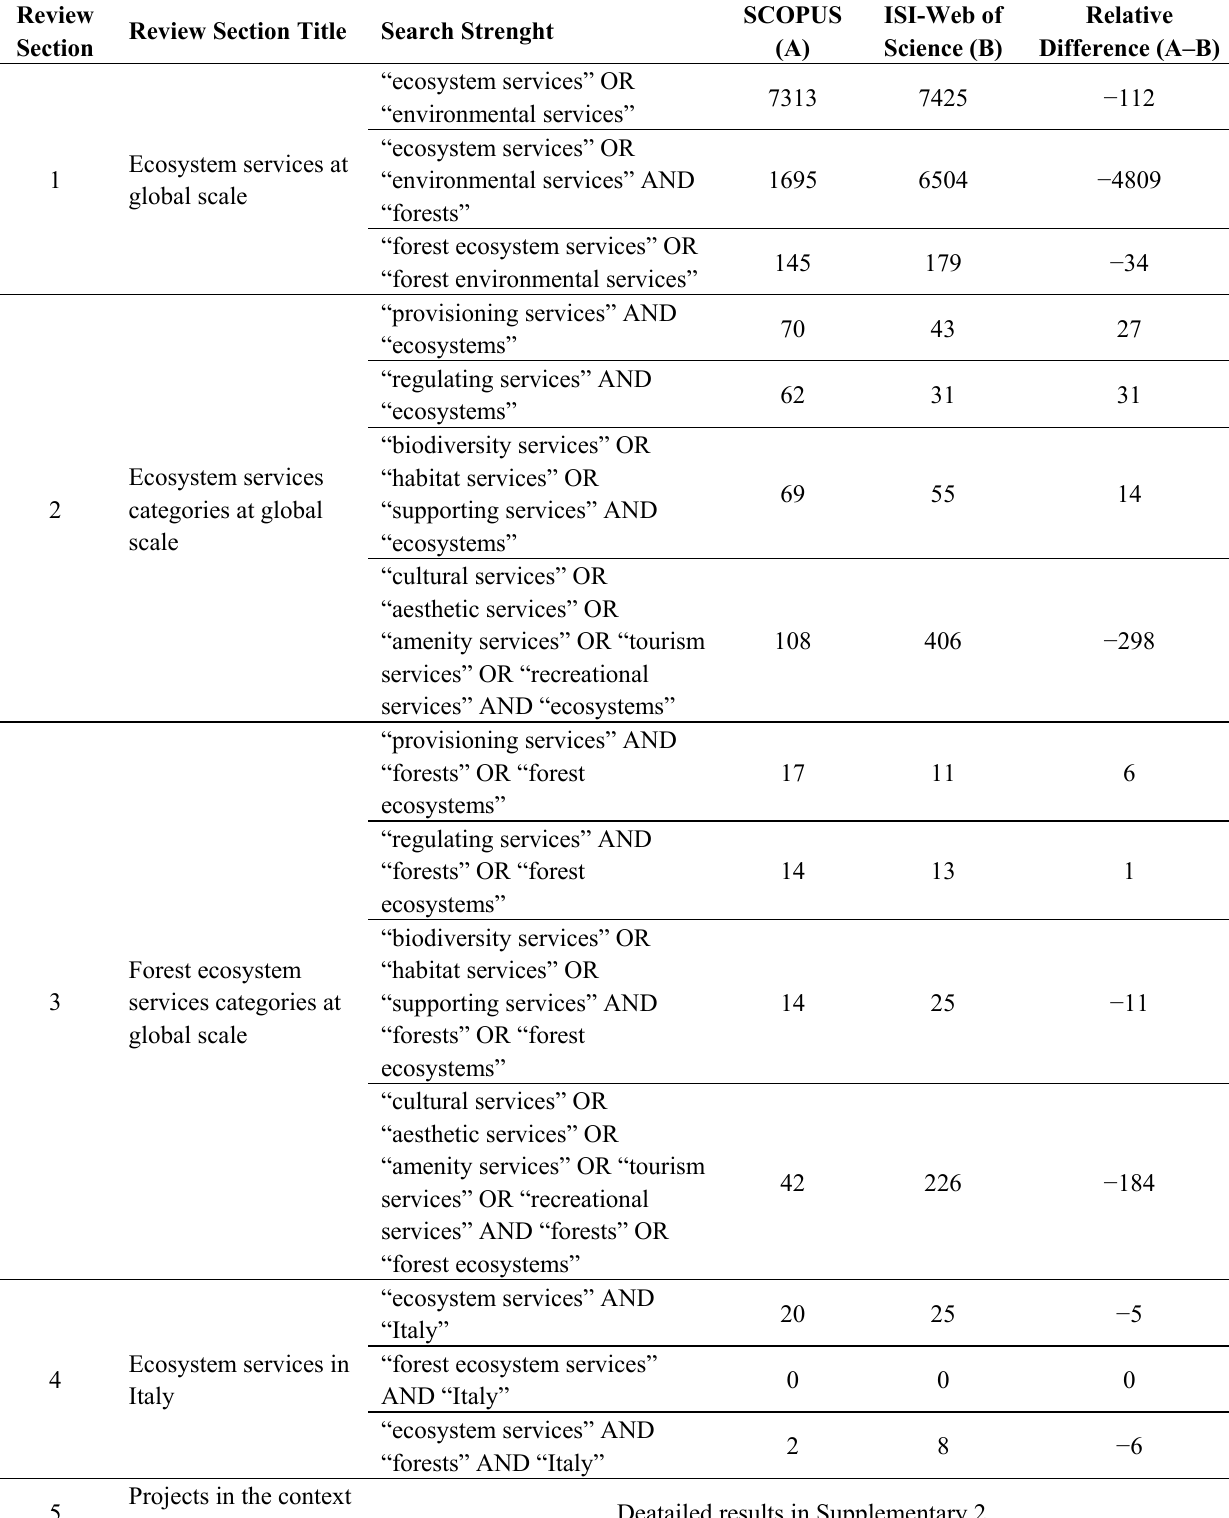
Table 3. Summary of review results in terms of number of records found, and relative differences per search engine (time period: 2000 to